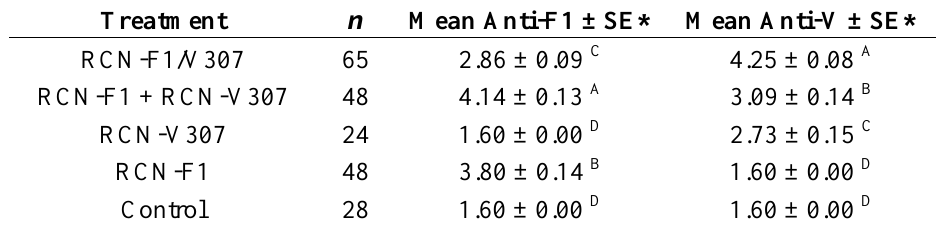
Table 4. Pre-challenge anti-F1 and anti-V IgG geometric mean titers ± standard error (SE) for A/J/mice averaged for each vaccine treatment over all